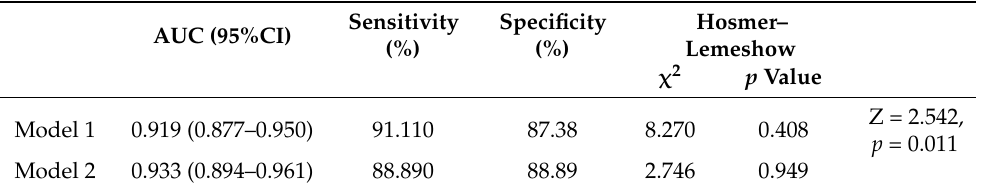
Table 5. Comparison of the diagnostic efficiency of the diagnostic models based on SDCT parameters and TK1.